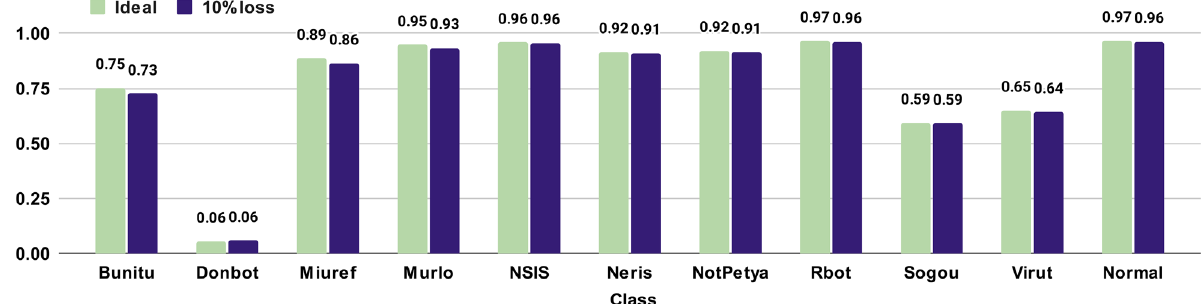
Figure 3. F1 scores for each traffic class on ideal conditions and on a saturated network with a packet loss probability of 10%.